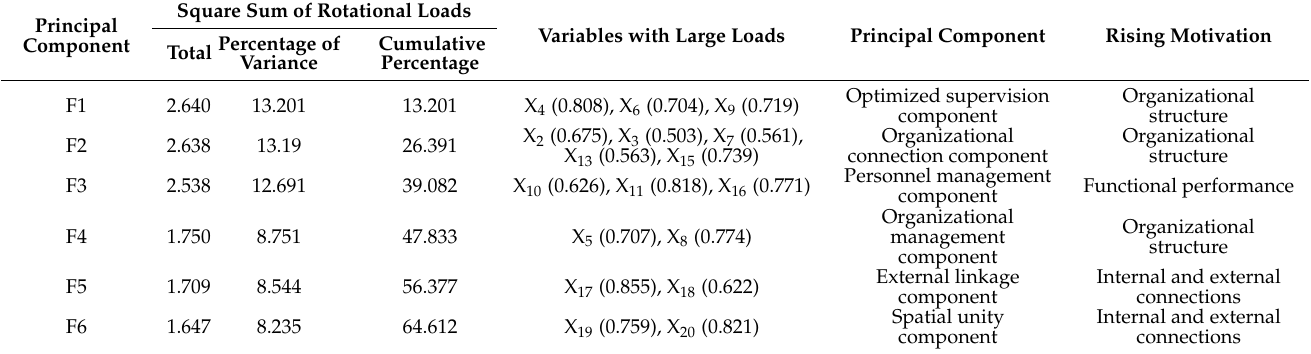
Table 6. Results of principle components analysis for the agricultural and pastoral areas. Square Sum of Rotational Principal Component